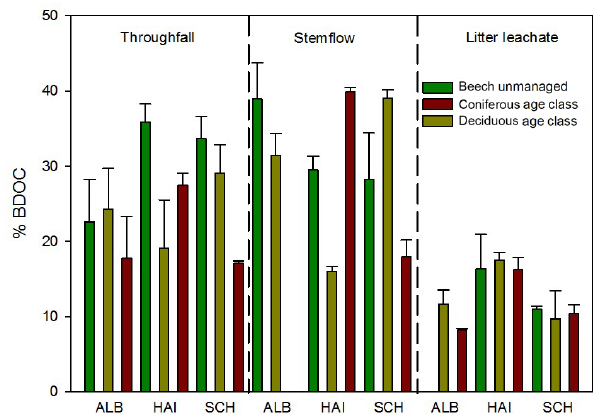
Figure 9. Percentage of biodegradable DOC (%BDOC) after 28 days of incubation in samples collected from different ecosystem fluxes. Bar chart: mean and SD of three replicates. TF: throughfall; SF: stemflow; LL: litter